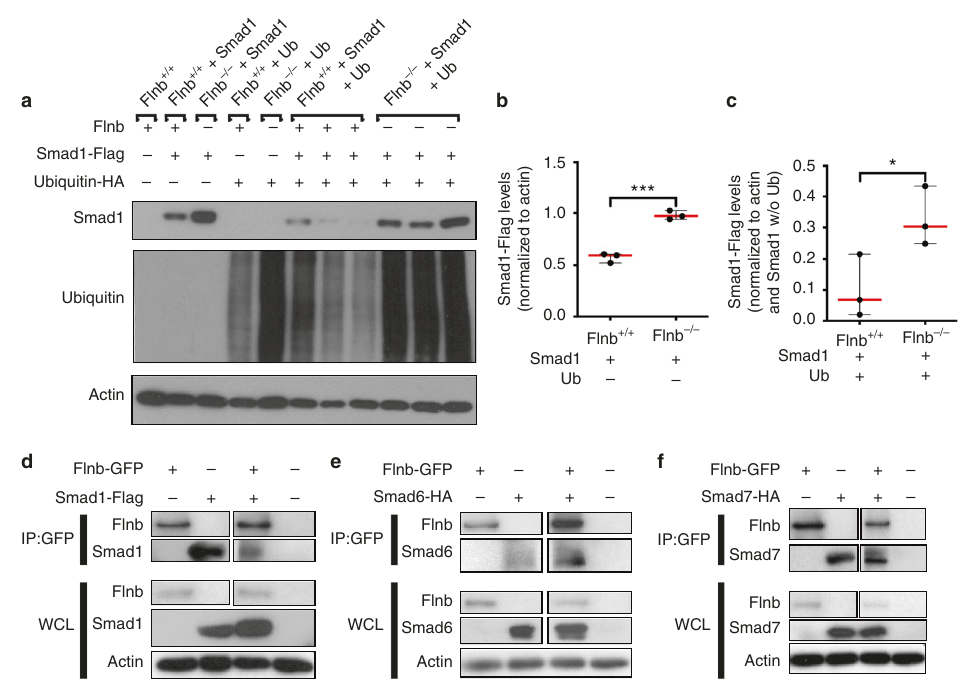
Fig. 4 Smad 1 degradation is less ef fi cient in Flnb − / − -transfected MEFs due to FLNB interaction with i-Smads. a Western blots of Flnb + / + and Flnb – / – MEF lysates nontransfected or transfected with Smad 1-Flag plasmid, ubiquitin-HA plasmid, or both. Blots were probed using antibodies against Flag, HA, and Actin. b Quanti fi cation of total Smad 1-Flag levels in Flnb + / + versus Flnb – / – MEFs normalized to actin levels. The results show that more Smad 1-Flag plasmid remained after transfection and that the 24-h recovery period indicated inef fi cient degradation in the absence of FLNB. c Quanti fi cation of total Smad 1-Flag levels in Flnb + / + versus Flnb – / – MEFs transfected with ubiquitin normalized to both Actin levels and Smad 1-Flag levels without ubiquitin transfection. The results again show that more Smad 1-Flag plasmid remained after ubiquitin transfection, indicating a lower ef fi ciency in ubiquitinated degradation in the absence of FLNB. n = 3, * P < 0.05, *** P < 0.001. d Western blots of lysates isolated from wild-type MEFs transfected with FLNB-GFP and Smad 1-Flag plasmids immunoprecipitated using an antibody against GFP. FLNB western blot was probed using a GFP antibody, and Smad 1 western blot was probed using a Flag antibody. The results showed the detection of Smad 1-Flag protein when lysates were immunoprecipitated using a GFP antibody, con fi rming the in vitro interaction of FLNB and Smad 1. e Western blots of lysates isolated from wild-type MEFs transfected with FLNB-GFP and Smad 6-HA plasmids immunoprecipitated using an antibody against GFP. The results showed the detection of Smad 6-HA protein when lysates were immunoprecipitated using a GFP antibody, con fi rming the in vitro interaction of FLNB and Smad 6. f Western blots of lysates isolated from wild-type MEFs transfected with FLNB-GFP and Smad 7-HA plasmids immunoprecipitated using an antibody against GFP. The results showed the detection of Smad 7-HA protein when lysates were immunoprecipitated using a GFP antibody, con fi rming the in vitro interaction of FLNB and Smad 7. n = 3, WCL Whole Cell Lysate, IP